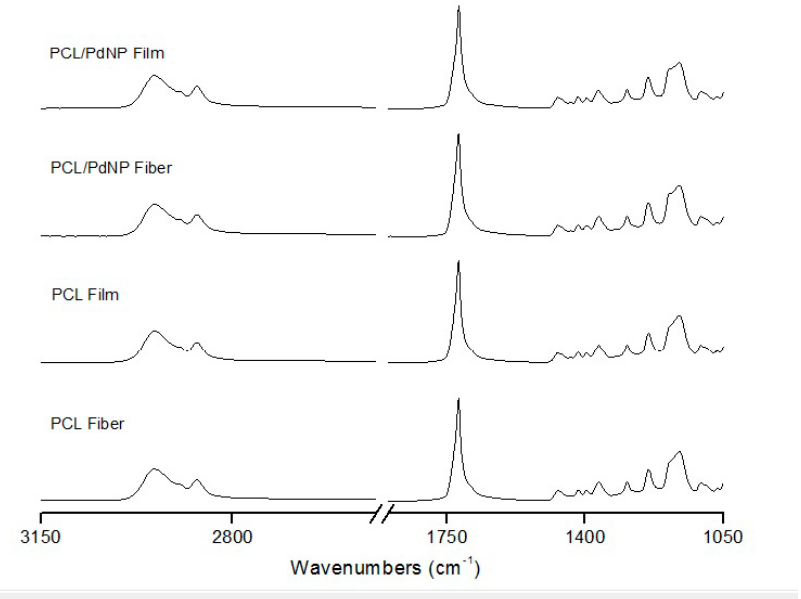
Figure 5. ATR-FTIR spectra of the electrospun PCL and the PCL/PdNP fiber mats and annealed films.